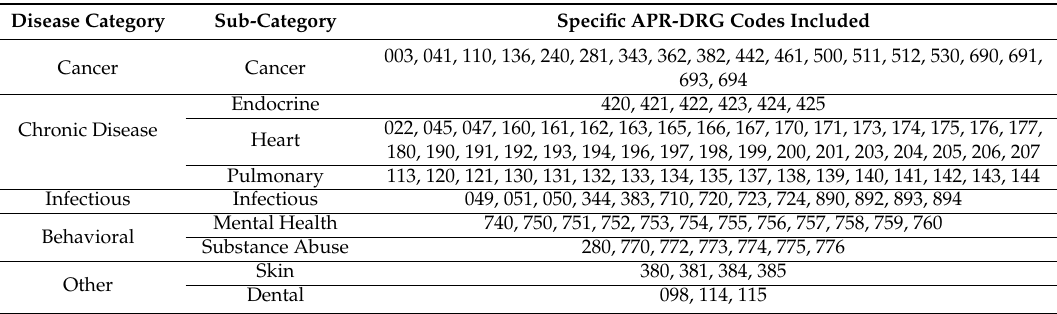
Table A1. Detail about APR-DRG-defined Disease Categories based on groupings of 3M’s